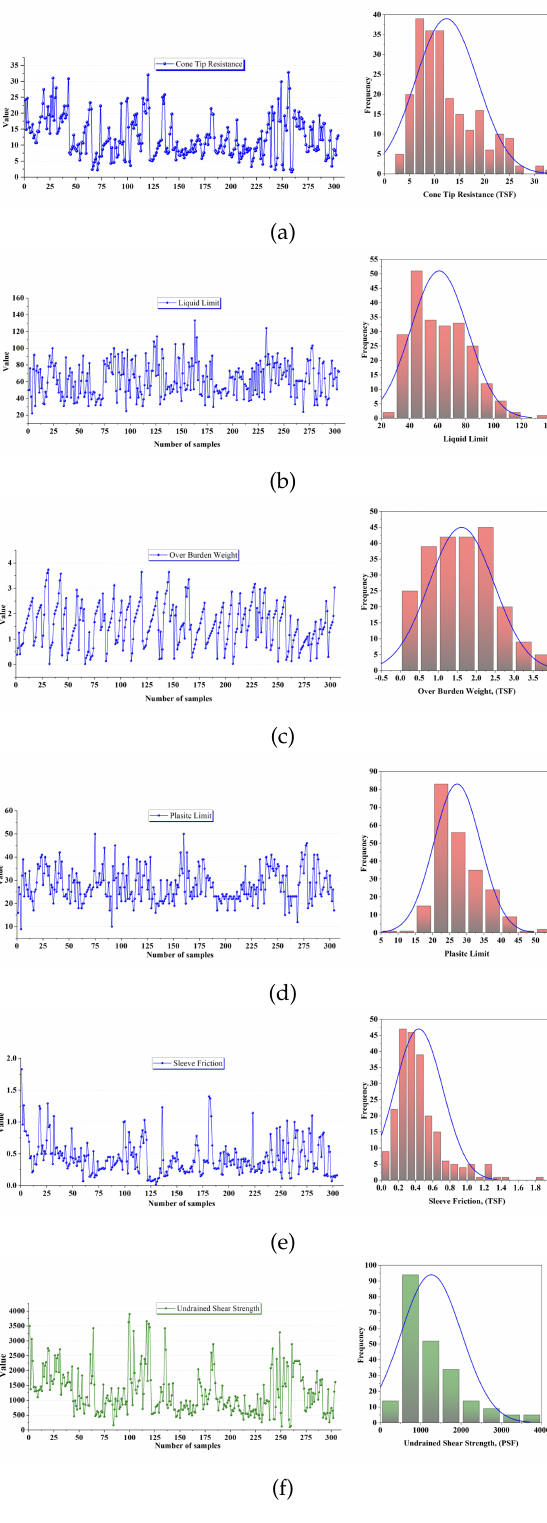
Fig. 3. Distribution and Histogram of input